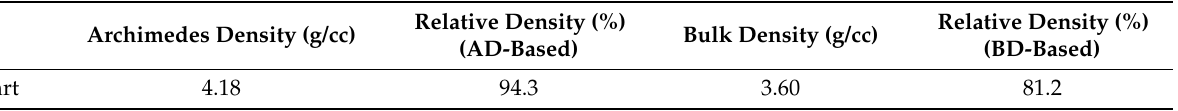
Table 3. Relative density and